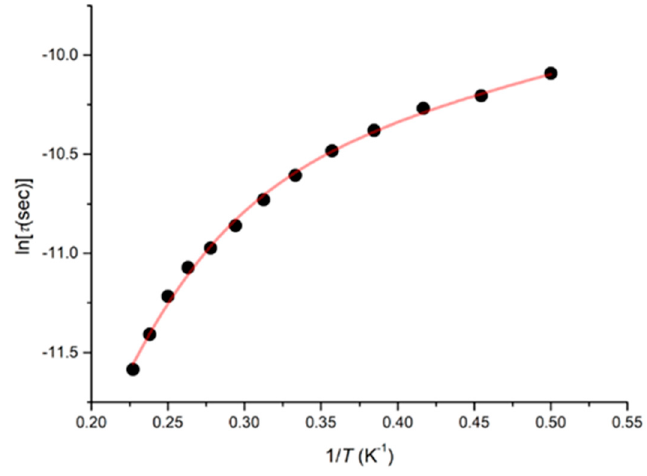
Figure 8. Plot of ln( τ ) vs. 1/ T for 1 . The red line represents the best fit according to Equation (2).